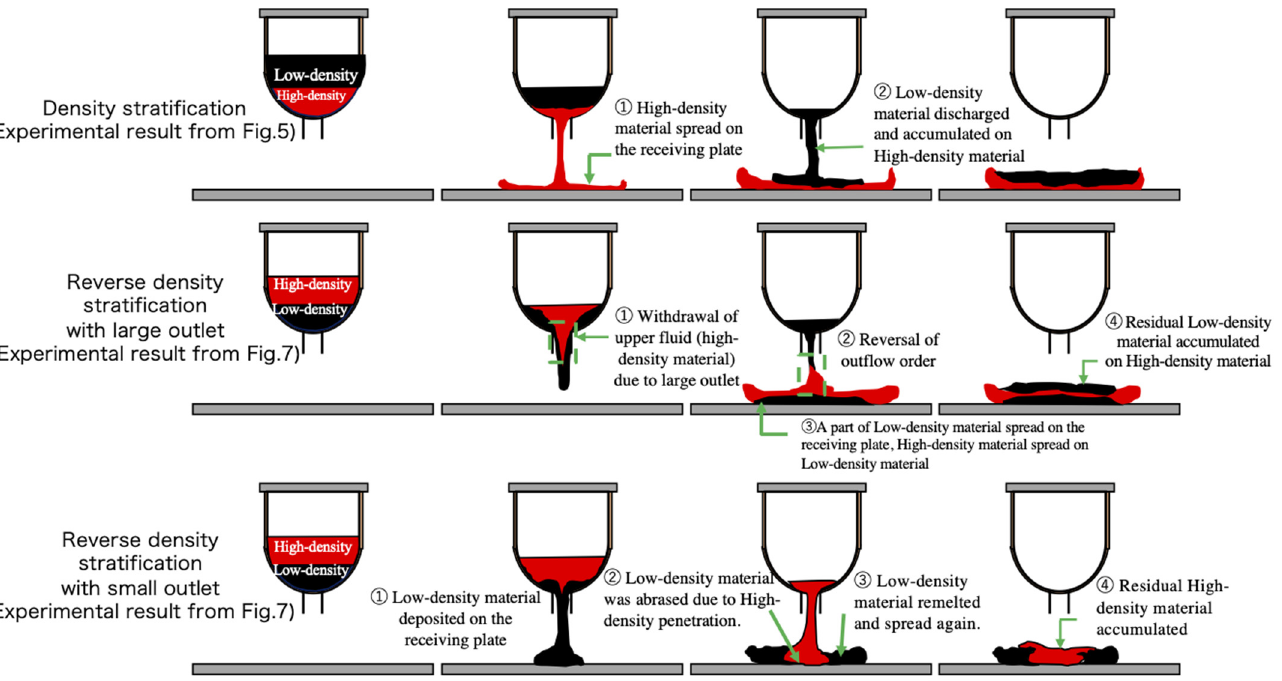
Figure 15. Summary of the spreading and deposition progression.